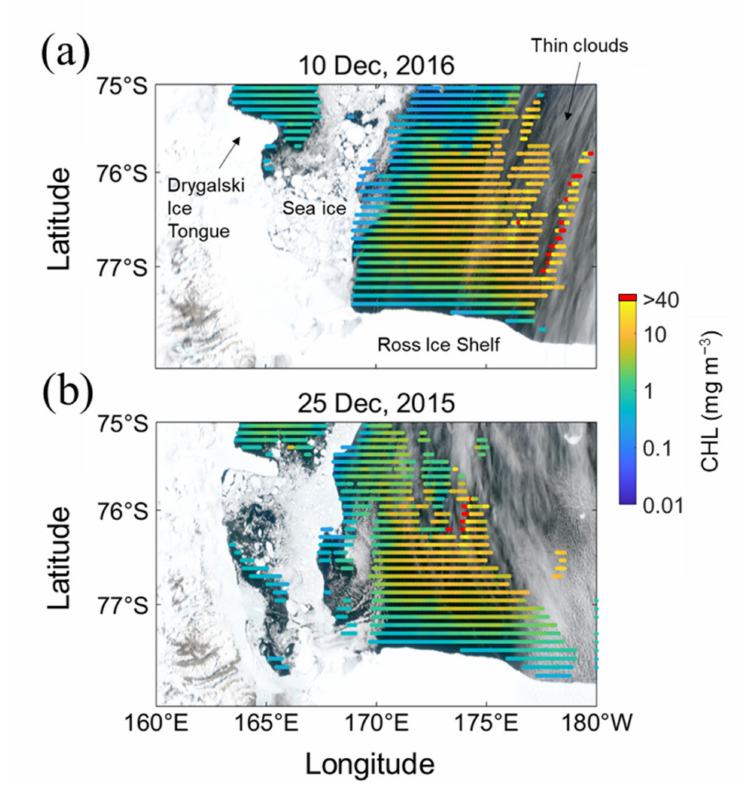
Figure 3. Examples with unlikely high CHL values induced by failures of flagging for ( a ) 10 December 2016 and ( b ) 25 December 2015, including VIIRS quasi-true color images (background) and CHL distribution (colored scatters). True color images were produced from one of several swath images acquired for the corresponding dates. High CHL values above 40 mg m − 3 were marked arbitrarily with red